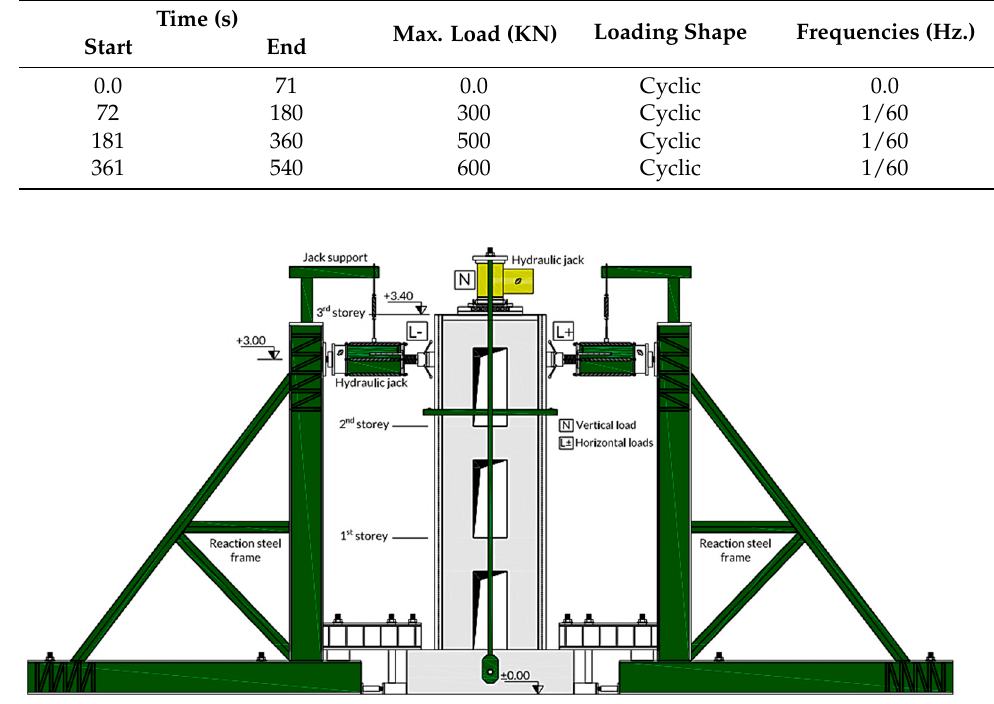
Figure 3. Cyclic loading arrangement.